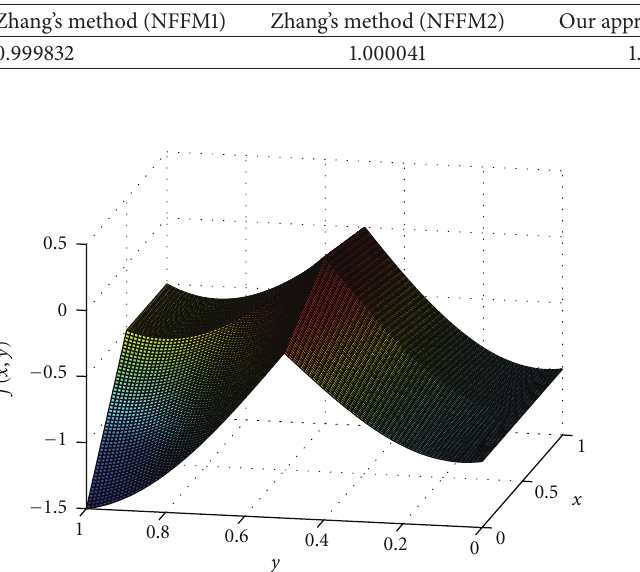
Figure 7: The graph of GD of 𝑓(⋅,⋅) with respect to 𝑦 for Example 3.